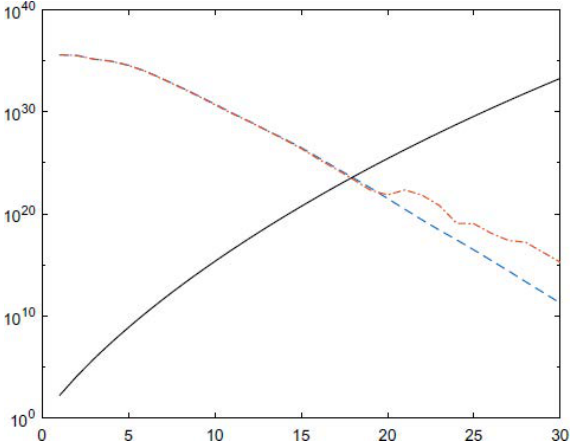
Fig. 7 The comparison curve between the full memory algorithm in this paper and the G-L definition @@LISAN method